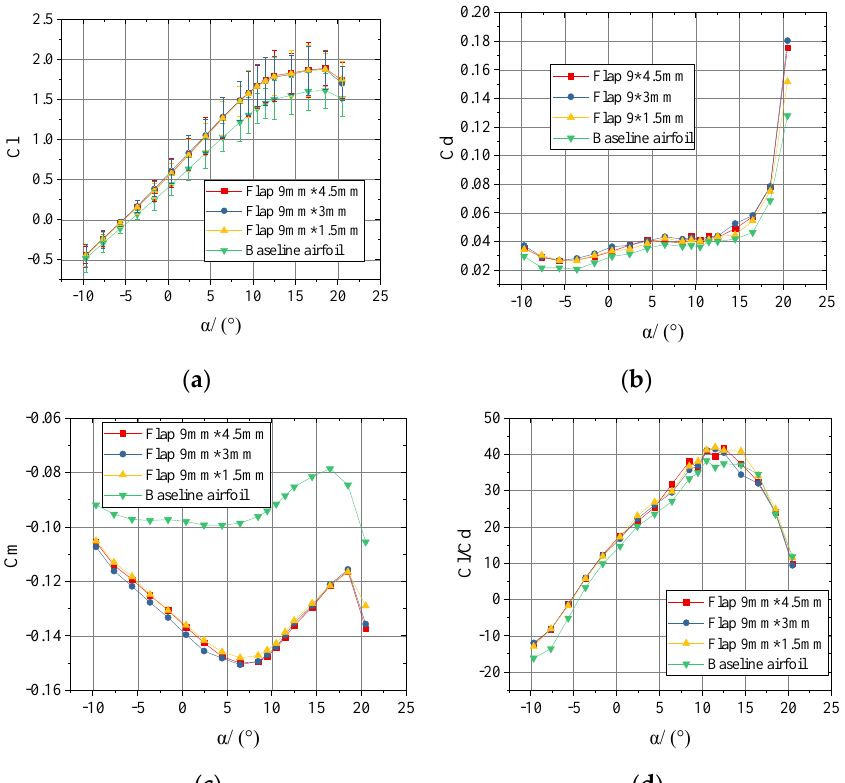
Figure 13. Variation of the aerodynamic characteristics with different thicknesses of Gurney flaps (T.I. of 10.5%, Re: 0.8 × 10 6 ). ( a ) Lift coefficient comparison; ( b ) drag coefficient comparison; ( c ) pitching-moment coefficient comparison; ( d ) lift-to-drag ratio comparison.